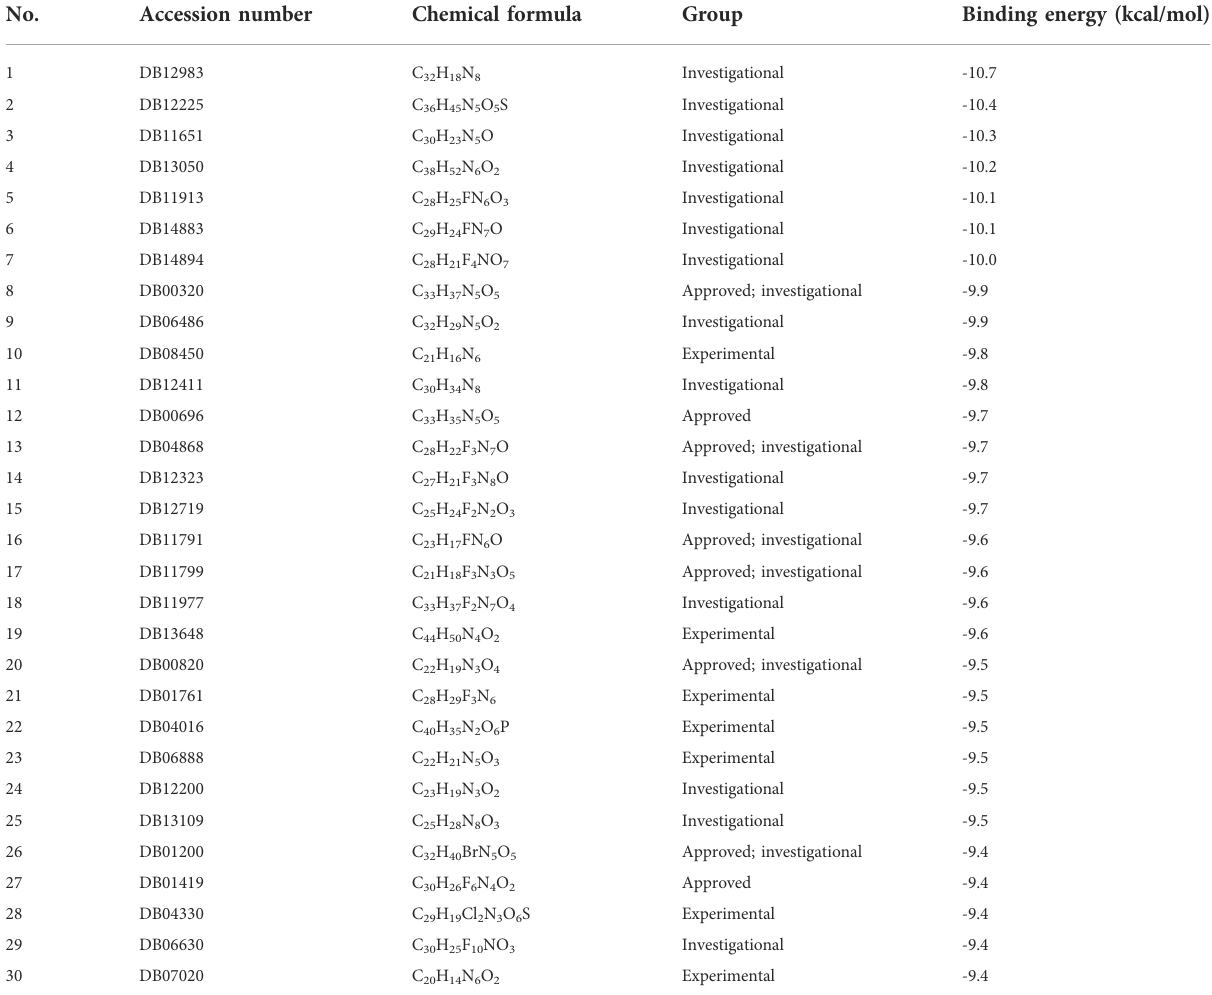
TABLE 2 Top 30 compounds from the docking